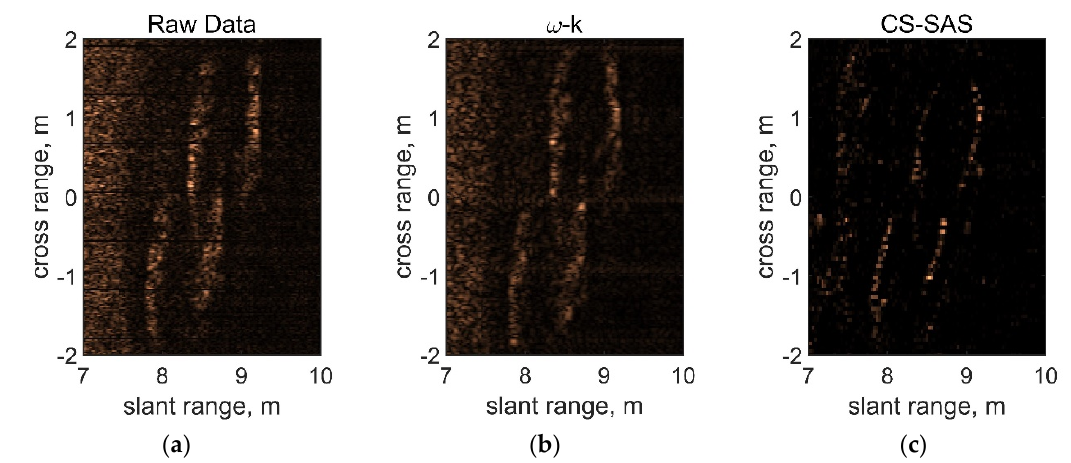
Figure 14. ( a ) Raw data; ( b ) result for the ω -k algorithm; ( c ) result for the CS-SAS algorithm.